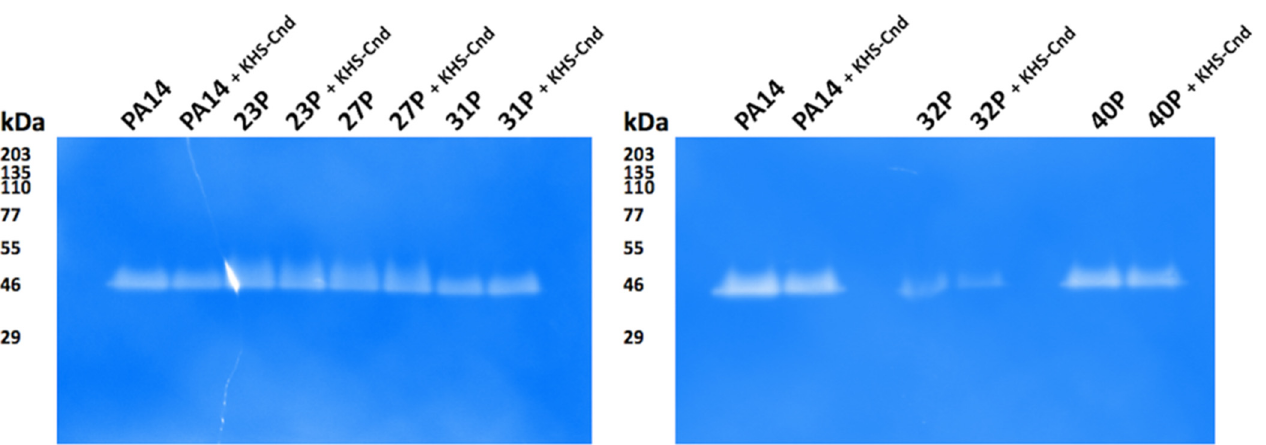
Figure 7. Gelatin-zymography to detect proteases secreted by clinical isolates of P. aeruginosa . Samples of unconcentrated culture supernatants were subjected to SDS-PAGE using 10% gels containing 0.2% gelatin. After gel incubation in renaturation buffer and Coomassie staining, clear bands in the zymograms corresponded to active proteases. The apparent molecular masses of protein standards are indicated in kDa.